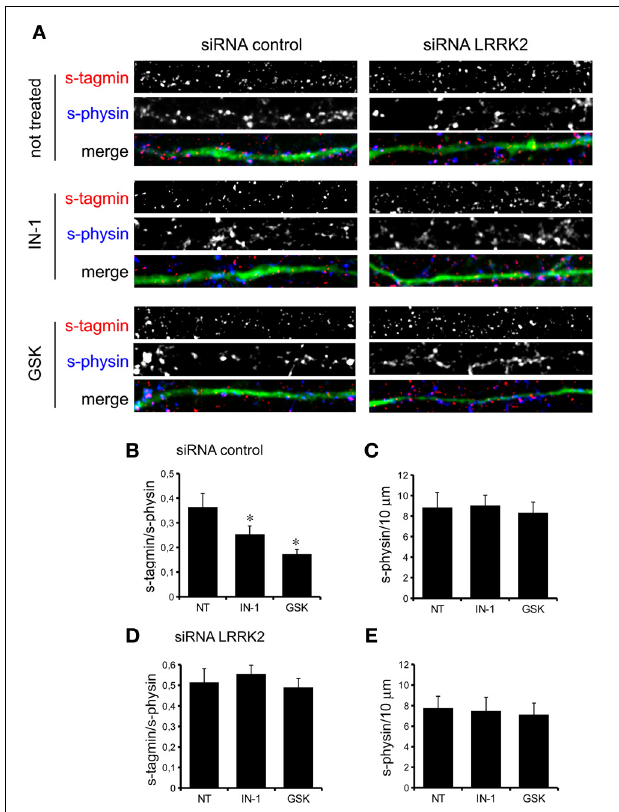
FIGURE 2 | LRRK2 kinase inhibition impairs SV trafficking. (A) The exo-endocytotic assay was performed on cortical neurons infected at DIV4 with virus expressing control siRNA and GFP and left untreated (NT) or incubated with IN-1 or GKS compound (both 2 µ M for 2h) before being tested at DIV14. Cycling SV appear as synaptotagmin (s-tagmin) positive clusters along neuron processes. Total SV pool was revealed by staining with anti-synaptophysin antibodies upon fixation and permeabilization. Images show signals acquired for synaptotagmin, synaptophysin and their superimposition plus GFP (merge). (B) The percentage of s-tagmin and s-physin positive clusters within the totality of s-physin positive clusters reflects the pool of cycling vesicles. (C) Total number of SV pools was not altered by treatment with IN-1 and GSK compound. The graph reports number of synaptophysin-positive clusters per 10 µ m of GFP-positive process. (D) Similar experiments were performed on cortical neurons infected on DIV4 with viruses expressing LRRK2 siRNA and GFP. In LRRK2 down-regulated culture SV cycling is not affected upon treatment with IN-1 and GSK compound (both 2 µ M for 2h). (E) Total number of SV pools was not altered by treatment with IN-1 and GSK compound. The graph reports number of synaptophysin-positive clusters per 10 µ m of GFP-positive process. Data are expressed as mean ± s.e.m.; ∗ p < 0 . 05 vs. not treated, n = 20, ANOVA followed by Dunn’s post-hoc test. Panel size is 35 × 5 µ m.